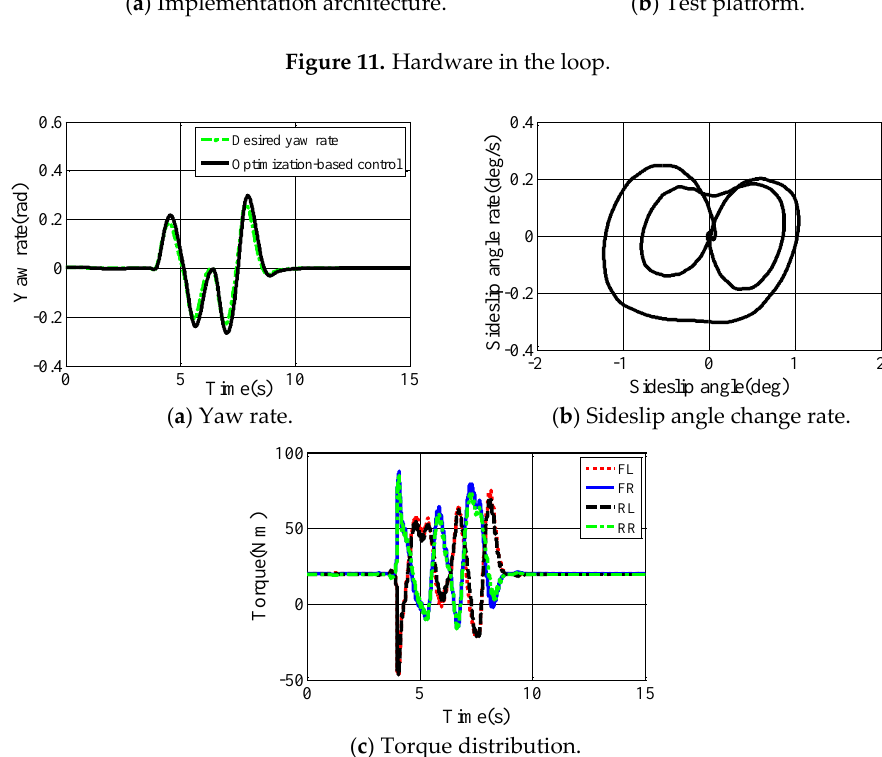
Figure 12. Experimental results for double lane change with high friction.